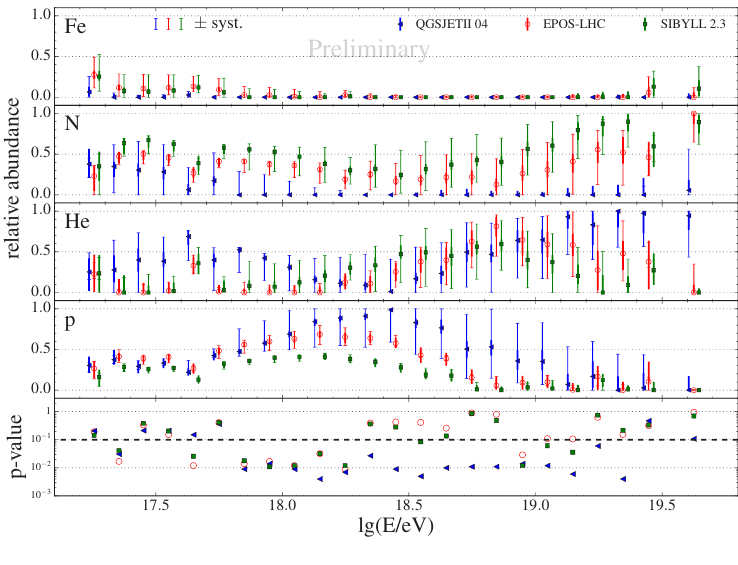
Figure 4. Results from a fit of the X max distributions with a superposition of H, He, N and Fe induced air showers. The error bars indicate the statistics (smaller cap) and the systematic uncertainties (larger cap). The bottom panel indicates the goodness of the fits ( p